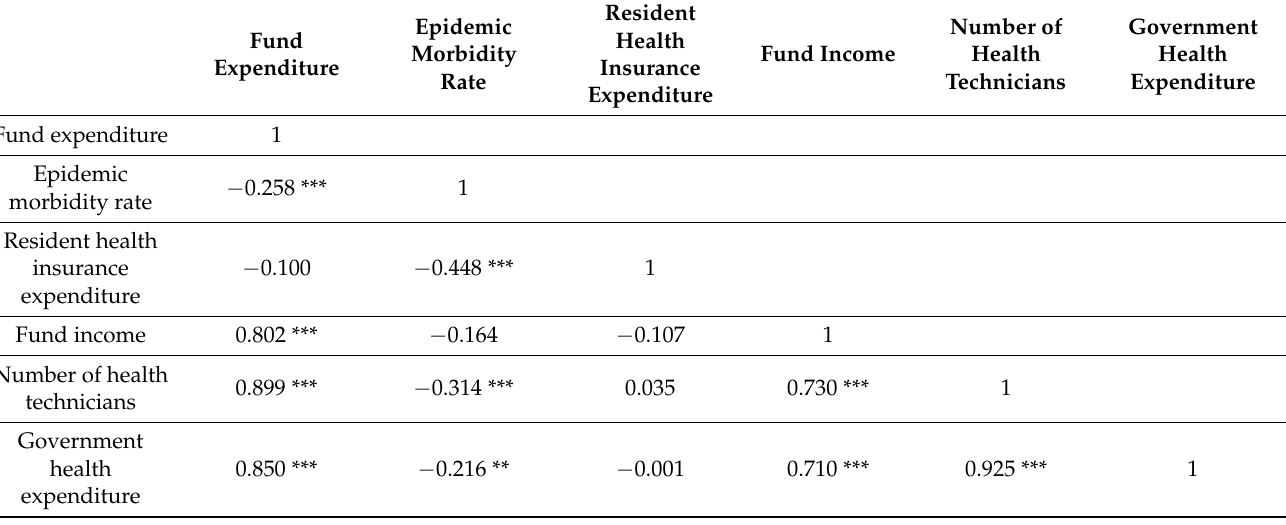
Table 3. Correlation analysis of the inputs and